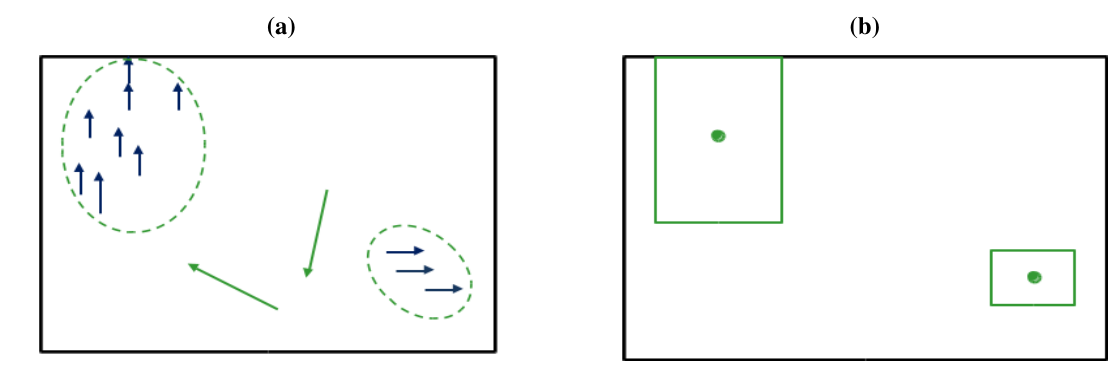
Figure 5. Pixel association into objects. Groups of vectors with similar orientation and magnitude are grouped as shown in (a). These groups are converted into dynamic